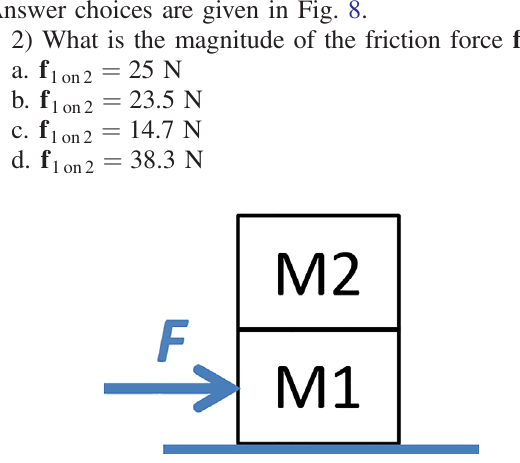
FIG. 7. Diagram provided in the prompt for version A of week 7, level 1 problems.